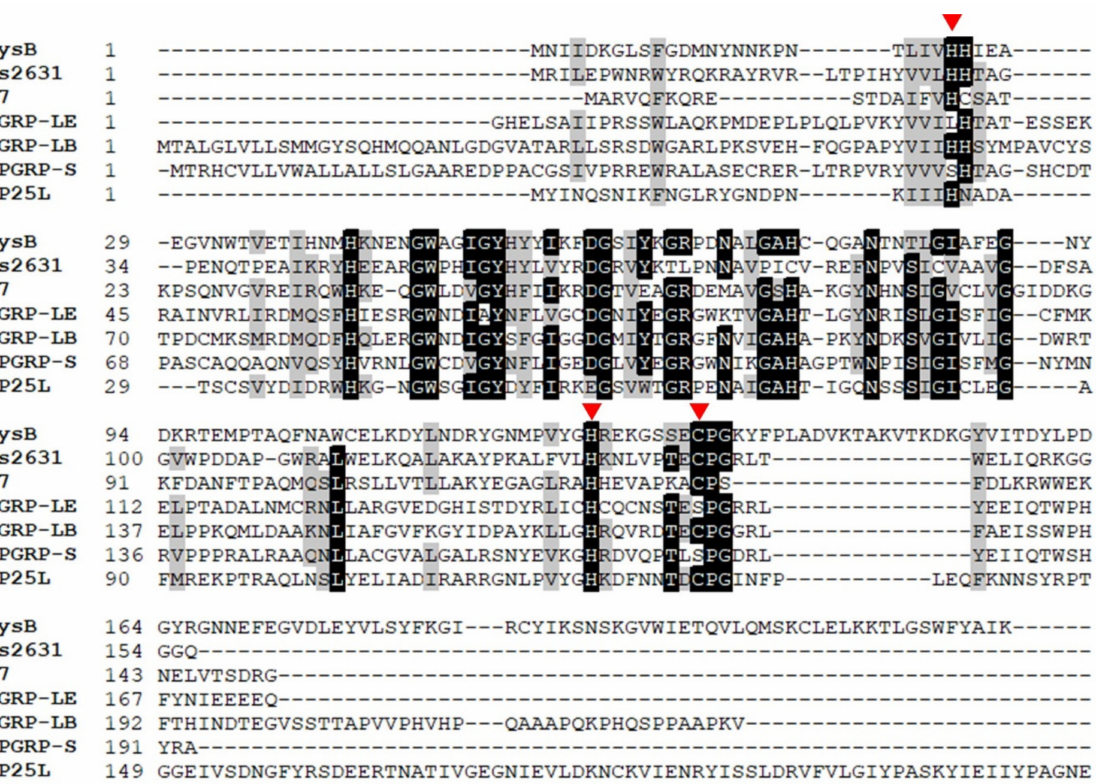
Figure 3. Multiple alignment of the amino acid sequence of LysB endolysin shows its homology to Ts2631 endolysin, T7 lysozyme, and eukaryotic peptidoglycan recognition proteins (PGRPs). GenBank or PDB accession numbers are LysB (ACD52487), Ts2631 from T. scotoductus phage vB_Tsc2631 (AIM47292.1), T7 from enterobacteria phage T7 (AAB32819.1), gPGRP-LE from D. melanogaster (PDB entry: 2CB3_B), PGRP-LB from D. melanogaster (PDB entry: 1OHT_A), CPGRP-S from C. dromedarius (PDB entry: 3O4K), CP25L from C. perfringens phage vB_CpeS-CP51 (AGH27916.1). The red triangles indicate residues responsible for Zn 2+ binding (H25, H126, C134). The alignment was generated with the Clustal Omega program with default options. The black background represents 100% amino acid sequence identity, while the gray background indicates amino acid conservation at